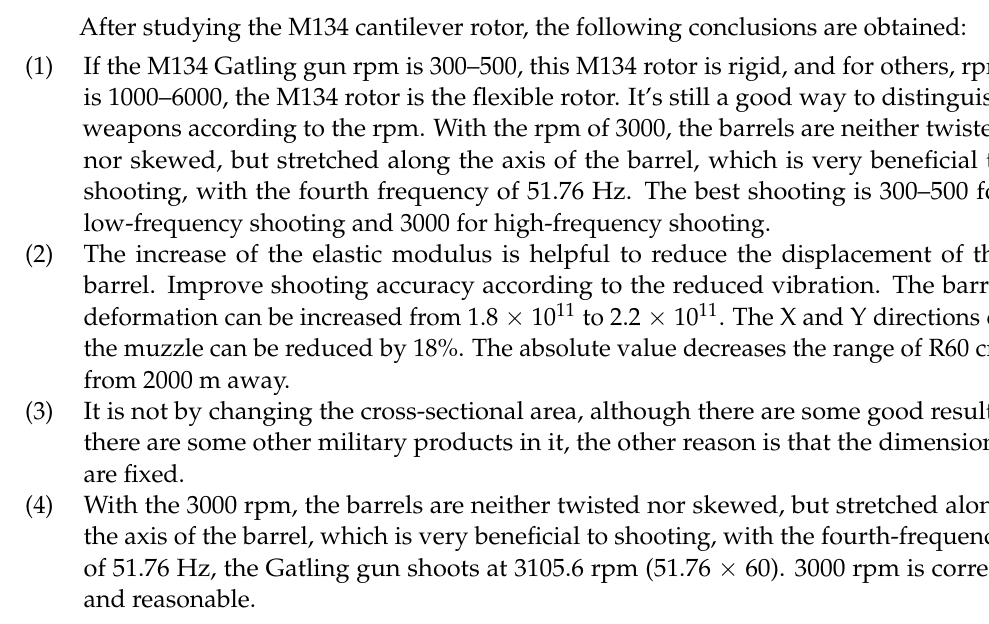
Figure 28. Two models calculation flying 2000 m.